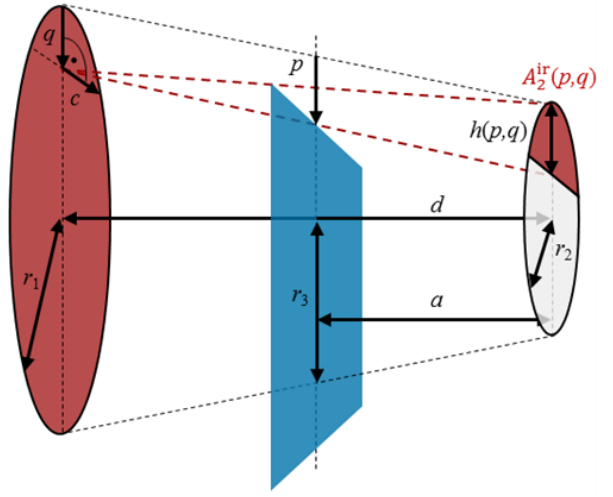
Figure 5. Geometry at the blackbody calibration set-up. On the left is the aperture of the blackbody and on the right the detector aper- ture. The chopper (blue) is located between the blackbody and de- tector. Its vertical position p defines the size of the part A ir of the detector area A 2 that is irradiated by the spot at the vertical position q on the blackbody